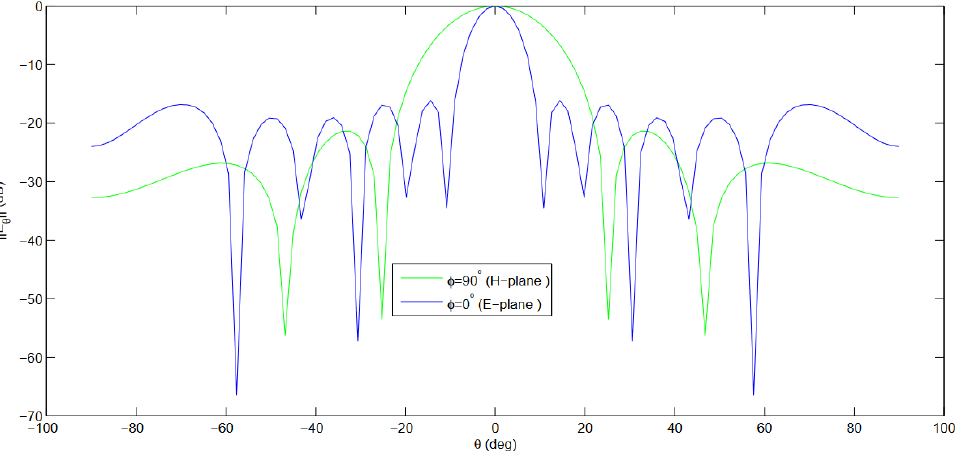
Figure 19. Radiation pattern computed with a MoM-GEC method against the periods at the operating frequency (f) of 5.4 GHz (periodic array).